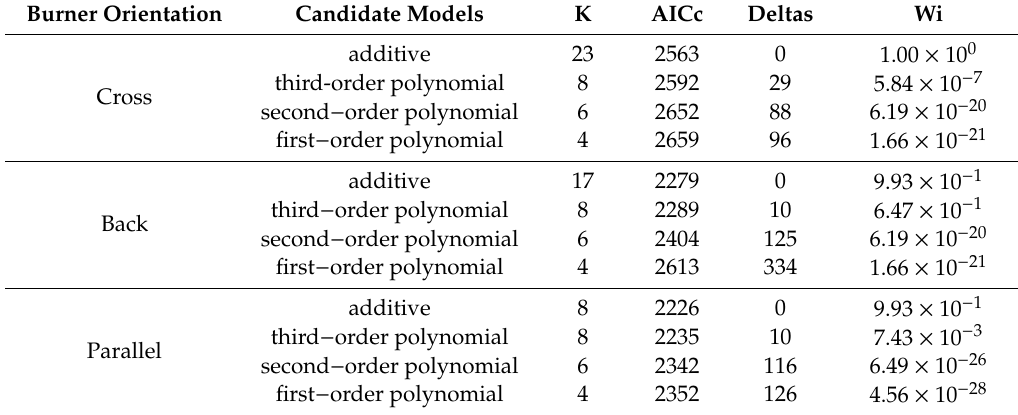
Table 1. Candidate models, number of parameters (K), and Akaike’s Information Criterion corrected for small sample size (AICc), increase over the lowest AICc ( ∆ AICc), and Akaike model weight (Wi) for models we used to examine the influence of propane dose (kg / ha) and canopy height (cm) on within-row flame temperatures for cross-, back-, and parallel-burner orientation, relative to rows of crops. Burner Orientation K